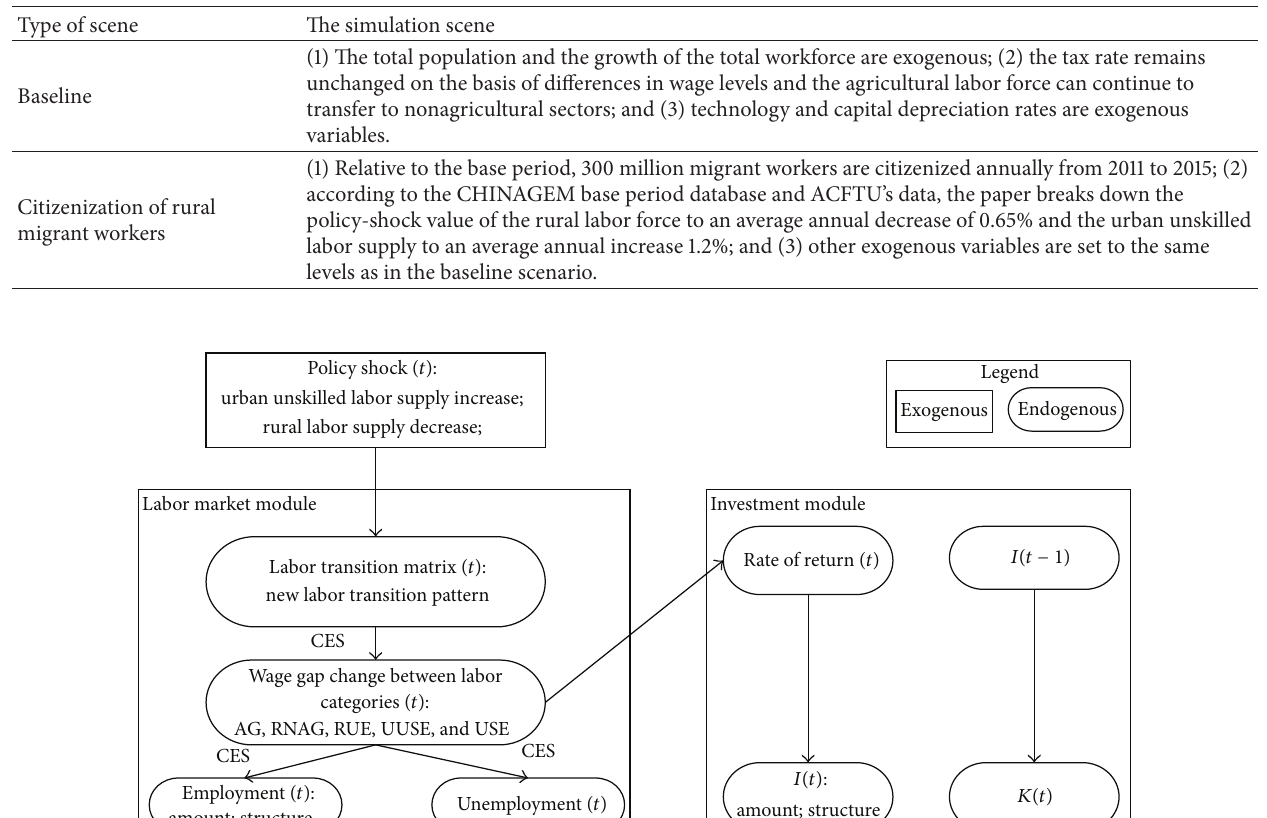
Table 1: Simulation scene design.